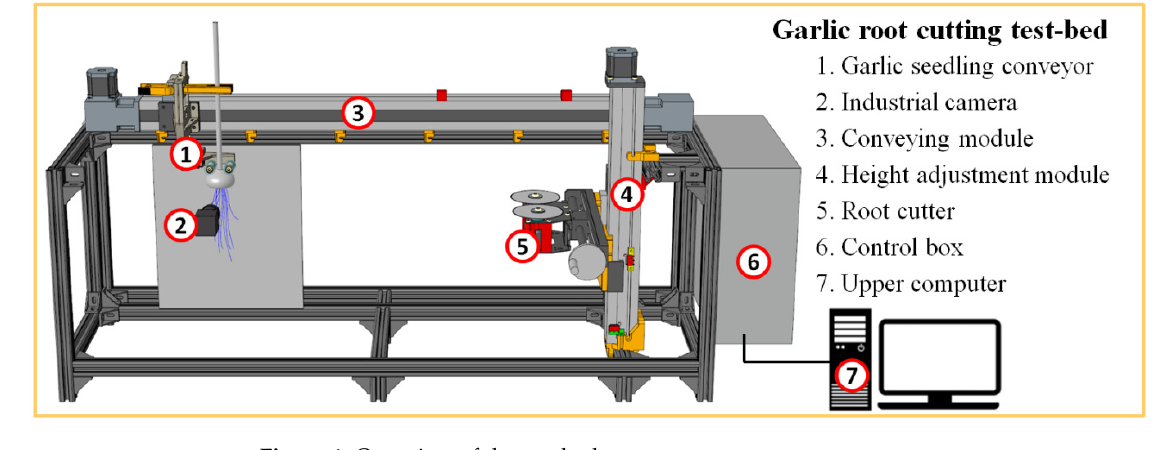
Figure 1. Overview of the test bed.